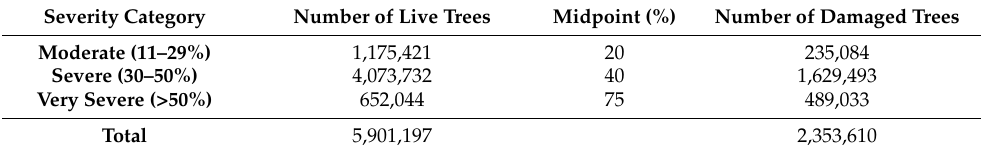
Table 4. Aerial survey severity categories and pre-storm and damage estimates in number of trees ( ≥ 12.7 cm/5 in d.b.h.) on forest land affected by the August 2020 Midwest Derecho, Iowa,